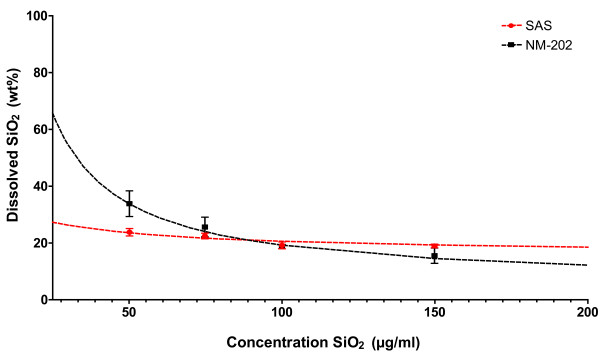
Dissolution behavior of SAS and NM-202 after digestion in vitro. The content of dissolved silica is given as a weight percentage of the total silica content at concentrations ranging from 50 to 150 μg/ml (n = 6). The dotted lines represent an extrapolated trendline for both samples. LOD: 5 μg SiO2/ml